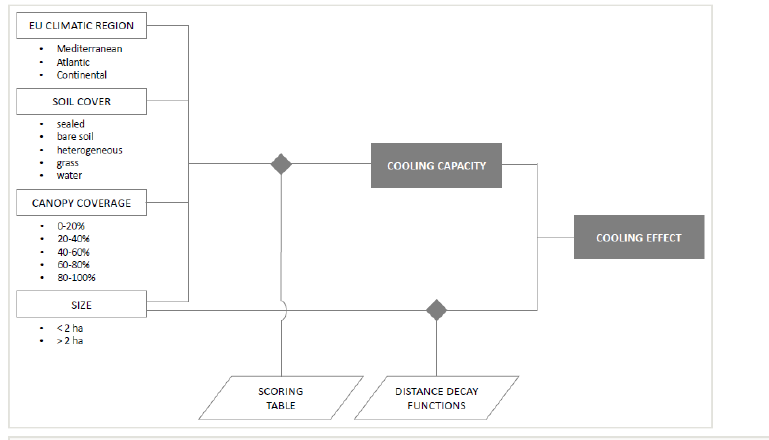
Flow chart of the model for mapping and assessment of the cooling capacity and cooling e ff ect of urban green infrastructure, building on Zardo et al. (2017). Input data are listed on the left. For model parameters (i.e. scoring tables and distance decay functions) refer to Geneletti et al. (2016), Zardo et al.